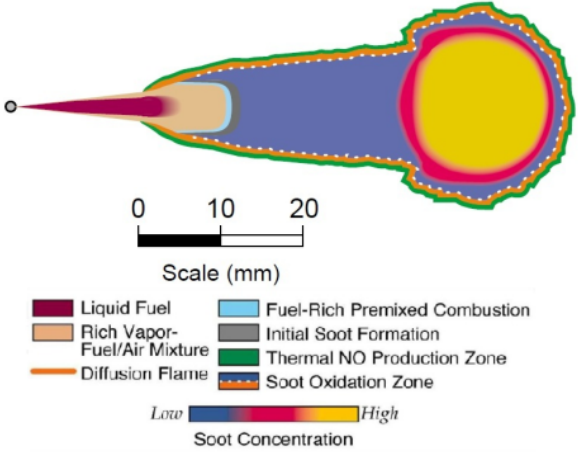
Fig. 1 Traditional diesel fuel injection and NO X and soot generation area